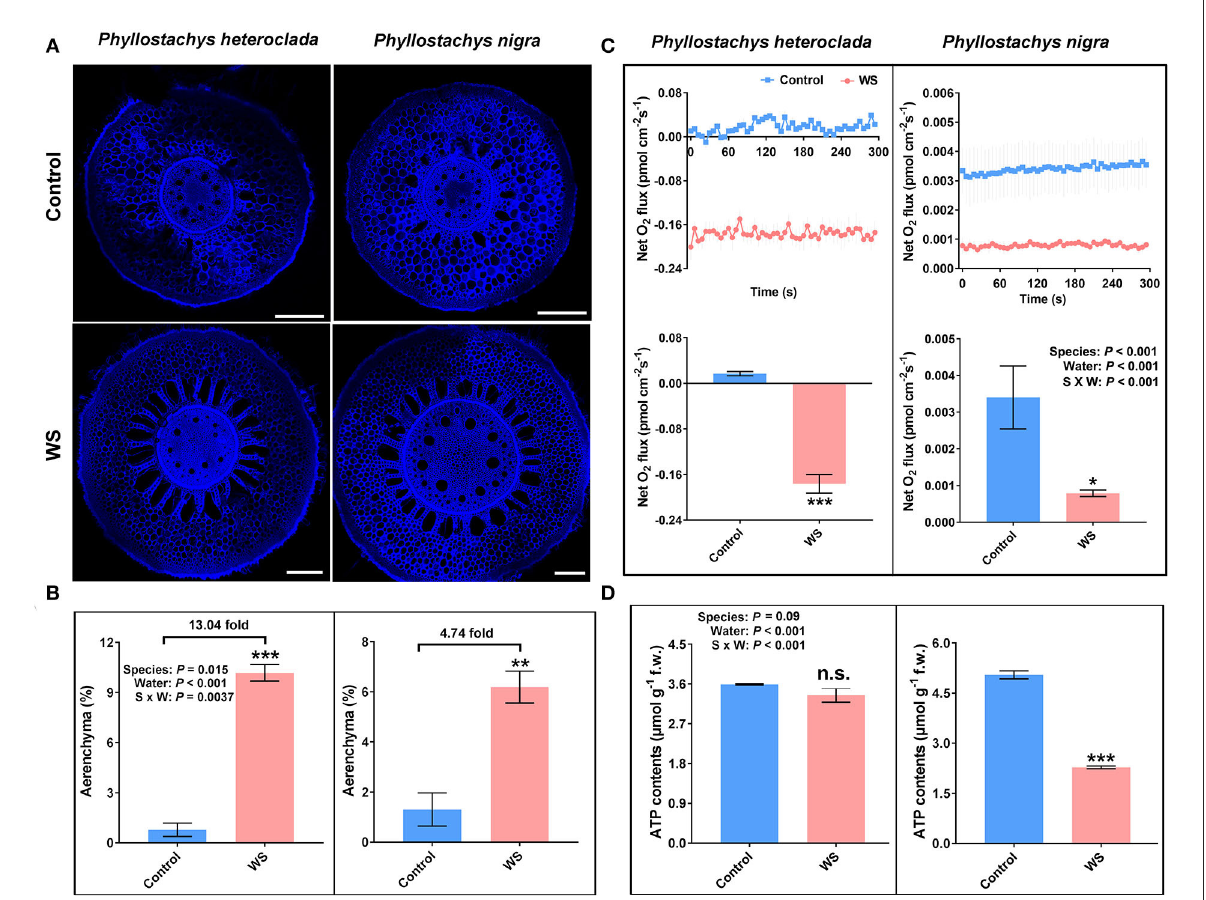
FIGURE3 Effects of waterlogging treatment on the formation of aerenchyma (A,B) , O 2 flux (C) , and ATP production (D) in the roots of Phyllostachys heteroclada and P. nigra . Data and bars represent the means ± SE of at least three independent replicates. Asterisks indicate the